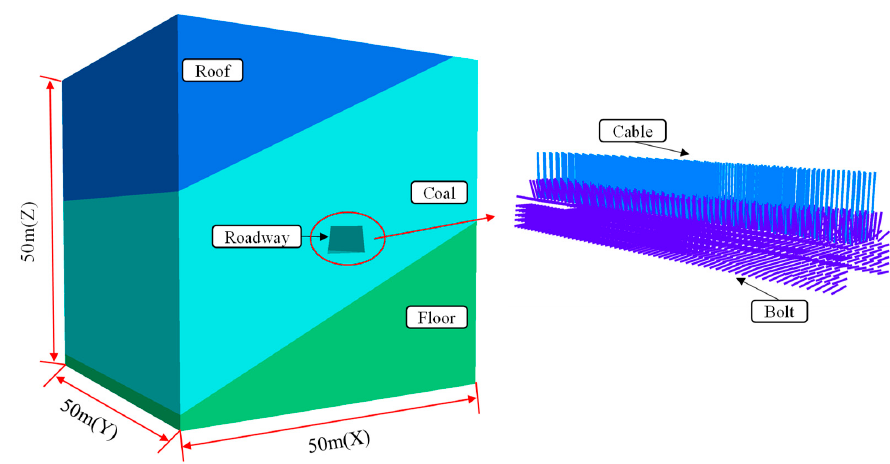
Figure 10. Numerical model. Table 3. Support structure parameters.